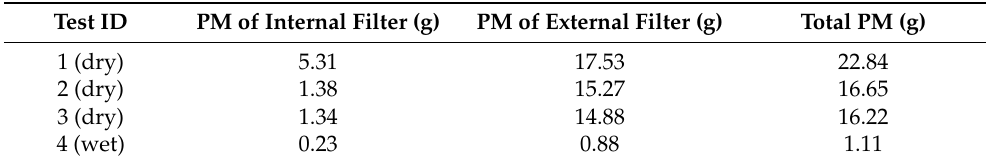
Table 6. Weight of PM captured by the filter .